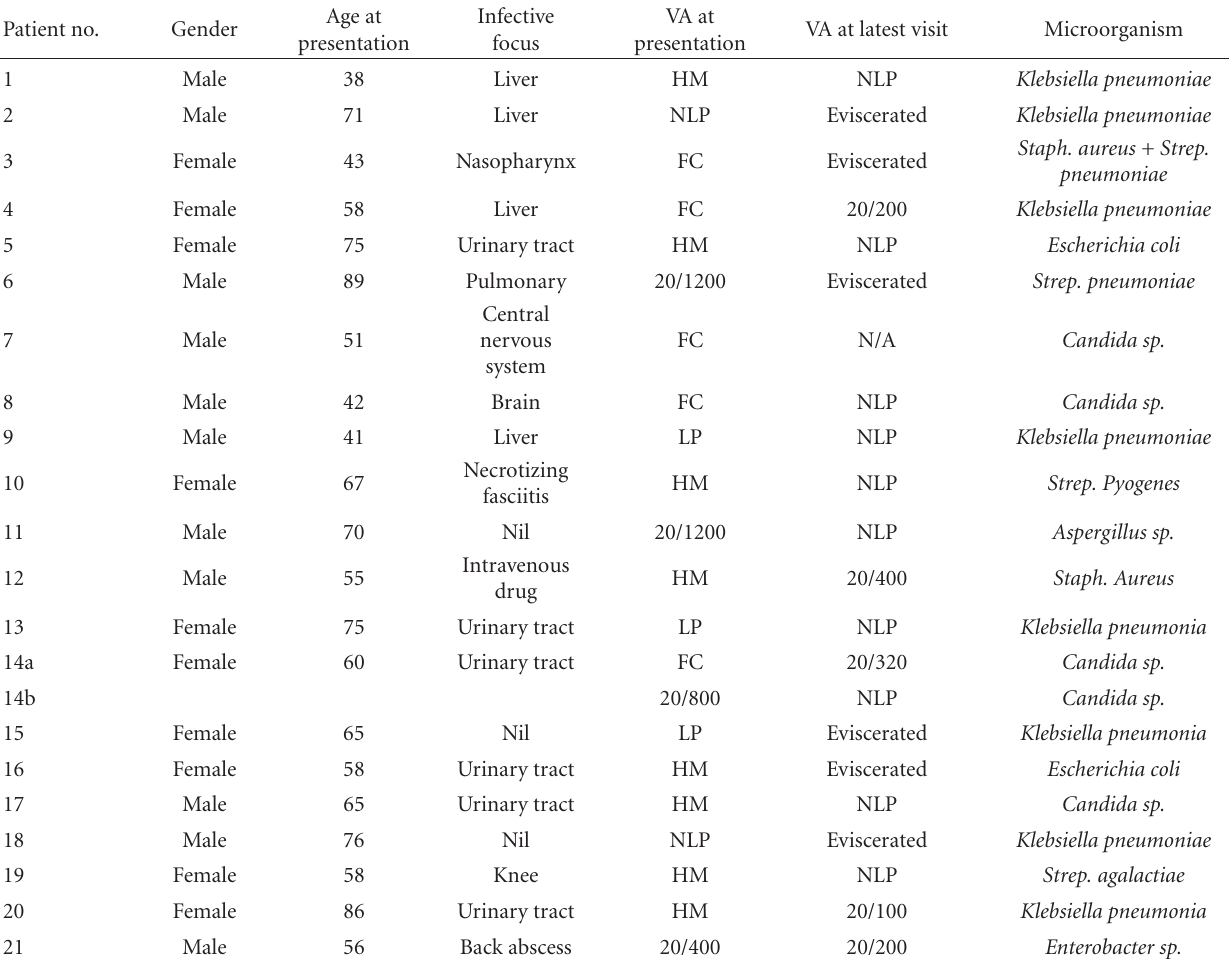
Table 1: Clinical features of 22 eyes of 21 patients with endogenous endophthalmitis. Patient no.